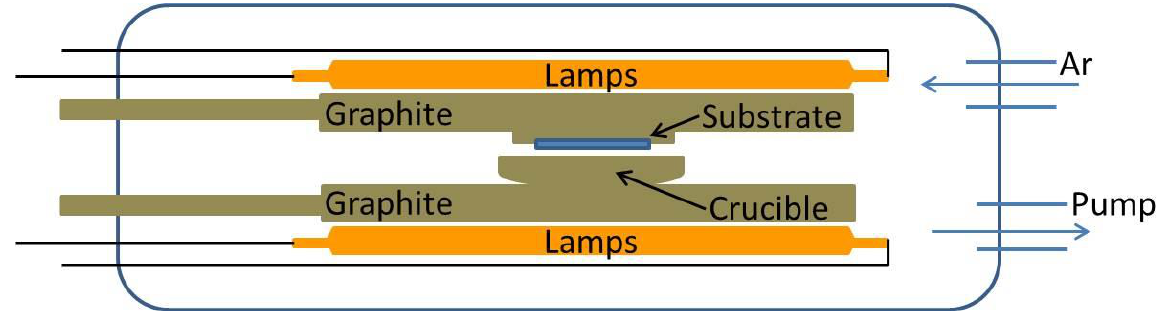
Figure 5. Schema of close space sublimation system.